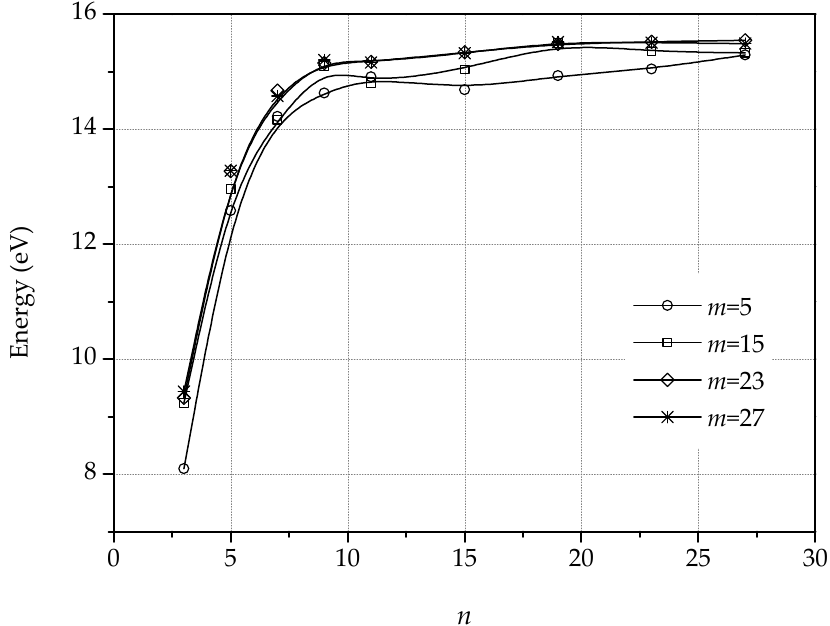
Figure 12. Stored energy of dislocation quadrupoles for the nonharmonic relaxation scheme as a function of dislocation lengths, n , for different separations between dislocation lines, m